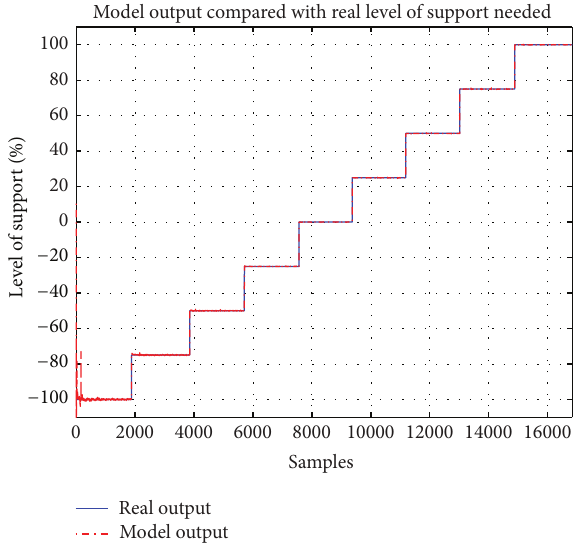
Figure 9: Modelling of the support function of the orthosis. The real function (blue) is compared with the modelled function (red, dotted). Model fit reaches over